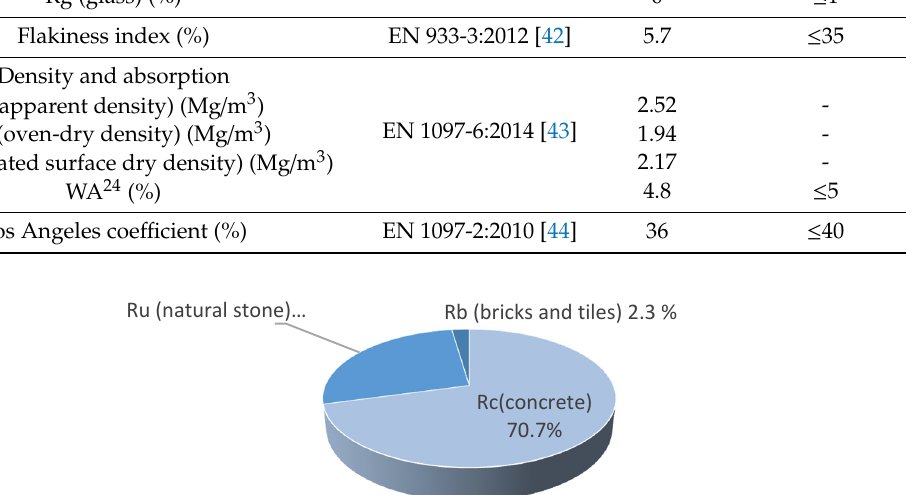
Table 4. Physical and mechanical characterization of the coarse natural aggregates.